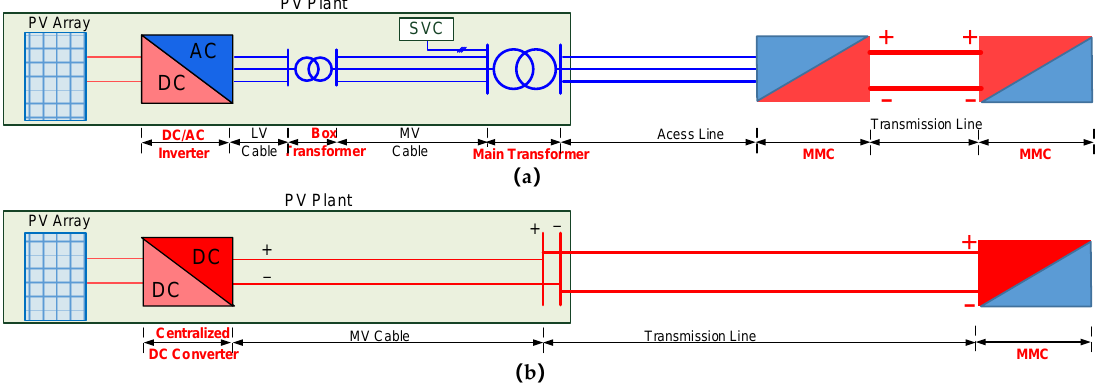
Figure 1. Topology of PV power plant collection and grid-connection scheme: ( a ) AC collection and grid-connection scheme; ( b ) DC collection and grid-connection scheme.